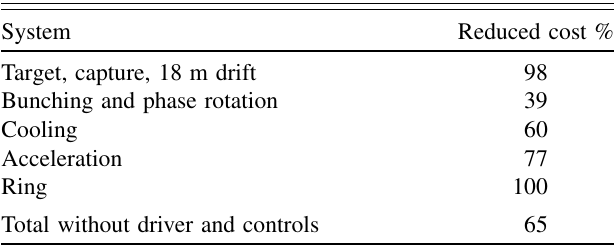
TABLE XI. Preliminary cost comparison between FS2 and